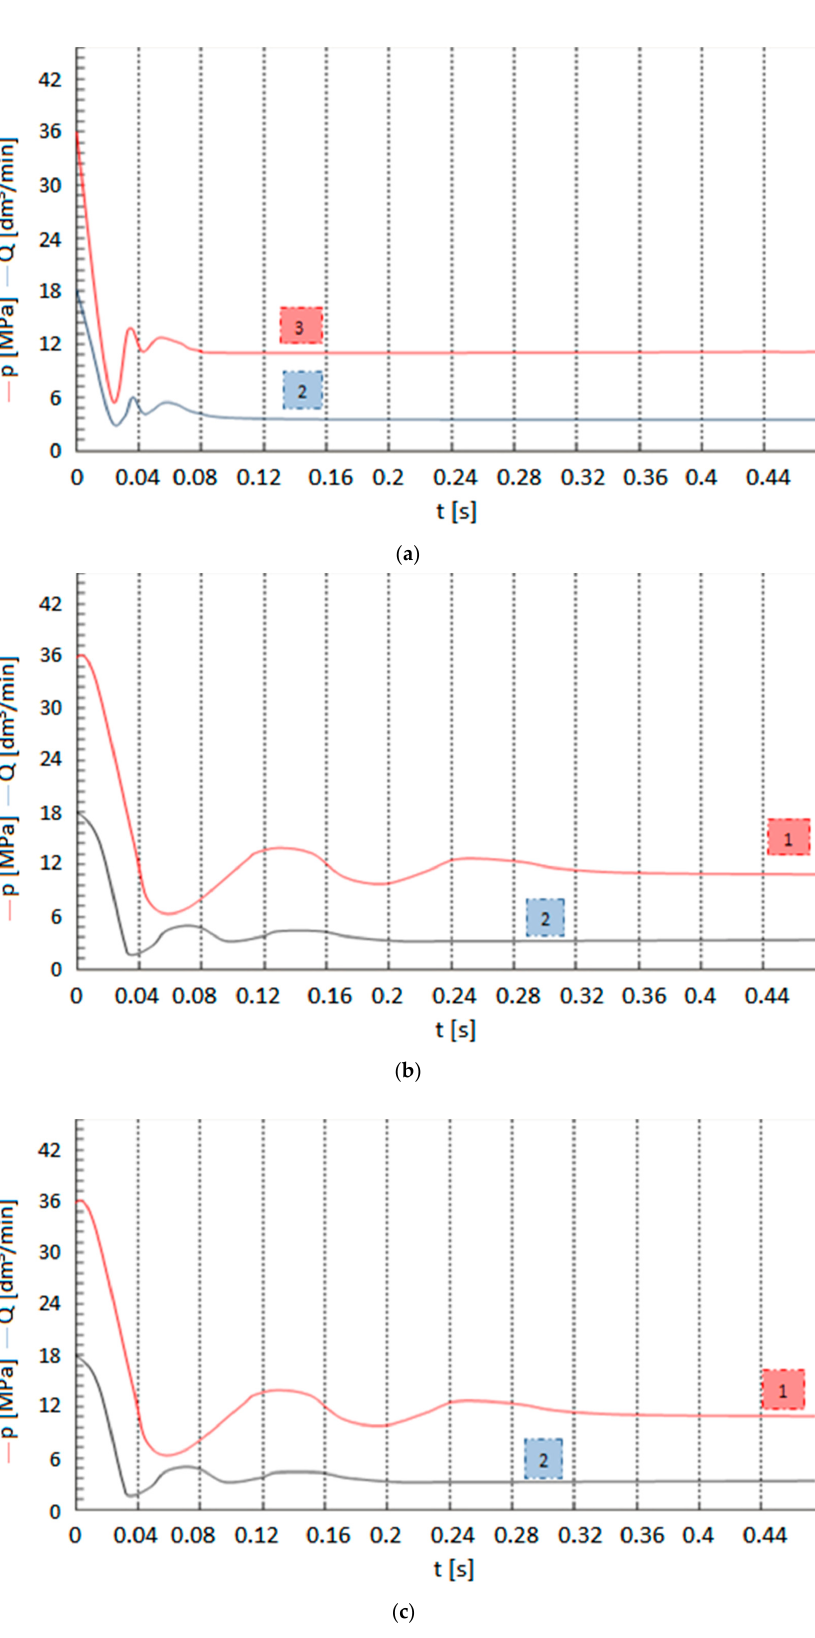
Figure 12. The Q and p time periods for code changes of the K p1 ·K p2 , Q rz , and F m parameters where Q rz : ( a ) 3(023), ( b ) 1(021), and ( c ) 1(220). Runs for a weighting factor value of w i = 3 for ( a ) and w i = 1 for ( b , c ).